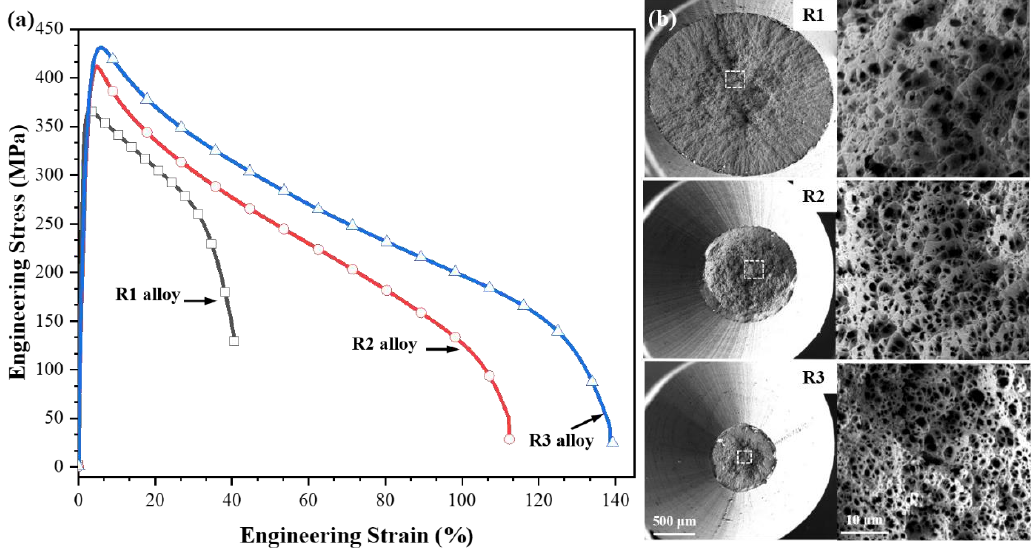
Figure 1. ( a ) Tensile stress-strain curves of different deformation samples and ( b ) fracture morphologies of samples.